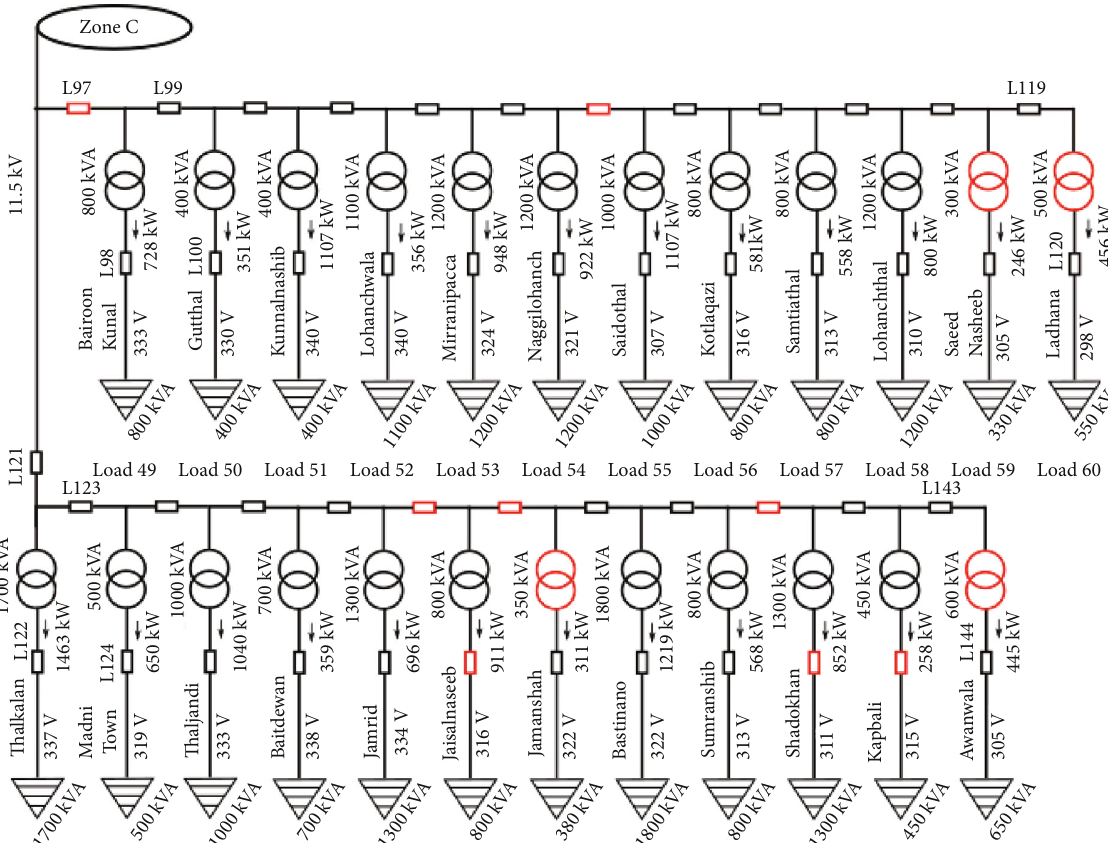
Figure 10: Implementation of zone C of the existing system on ETAP.